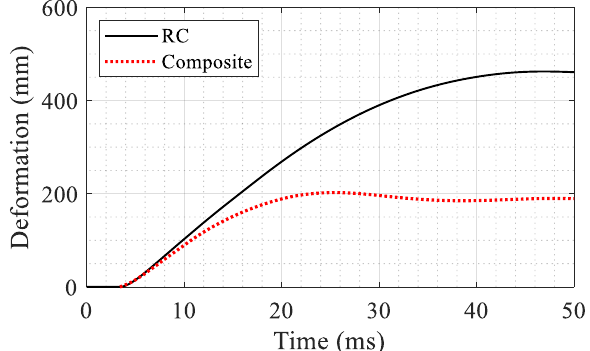
Figure 19. Comparison of the mid-height lateral deformation of the columns under blast loading (with no axial load).